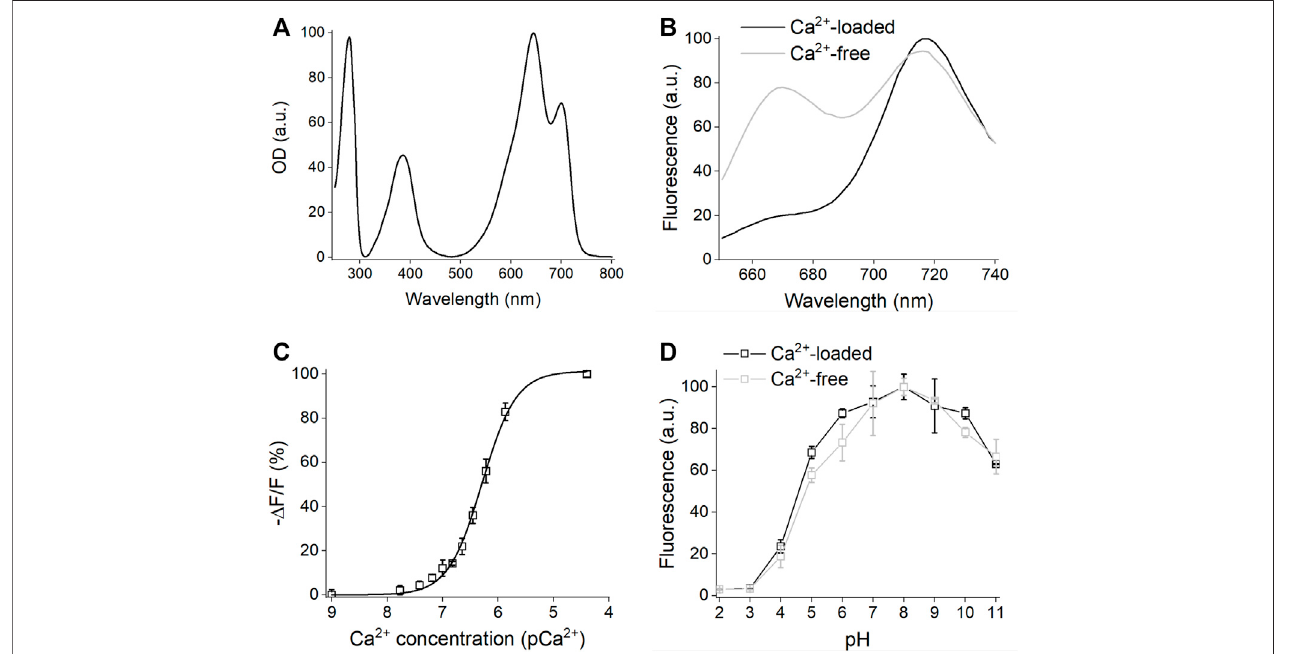
FIGURE 2 | In vitro characterization of iGECInano. (A) Absorbance spectrum of puri fi ed iGECInano. (B) Fluorescence spectra of iGECInano in HeLa cells lysate in thepresenceof1 mMCa 2+ (blackline)or1 mMEGTA(grayline). (C) Dependenceofpuri fi ediGECInano fl uorescenceonCa 2+ concentration. (D) Dependenceofpuri fi ed iGECI fl uorescence on the pH value in the presence of 1 mM EGTA (gray), or 1 mM Ca 2+ (black). Error bars are SEM, n = 4 experiments.